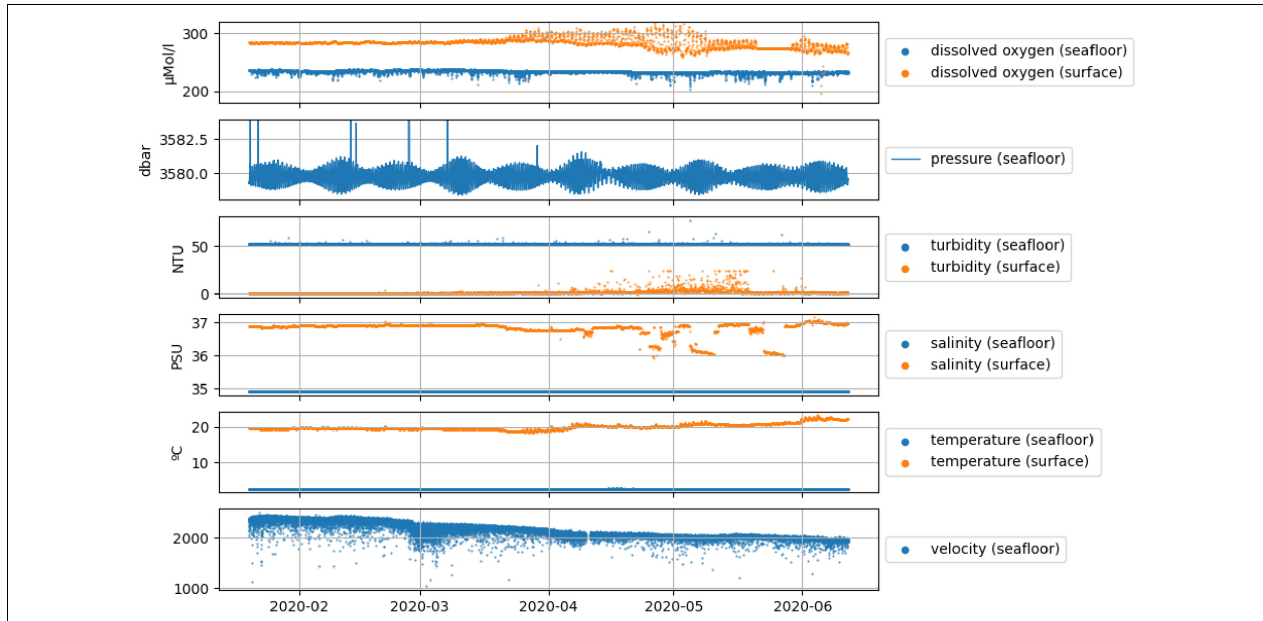
FIGURE 10 | EGIM (blue) and surface buoy (orange) observations of dissolved oxygen, pressure, turbidity, salinity and temperature at ESTOC, in 3,600 m depth. Pressure and current velocity are not measured at the